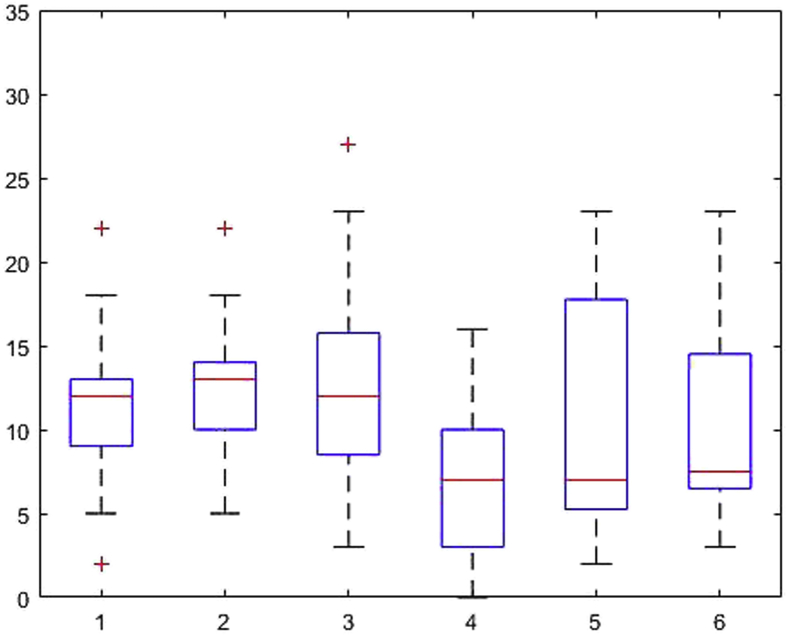
Details delayed.